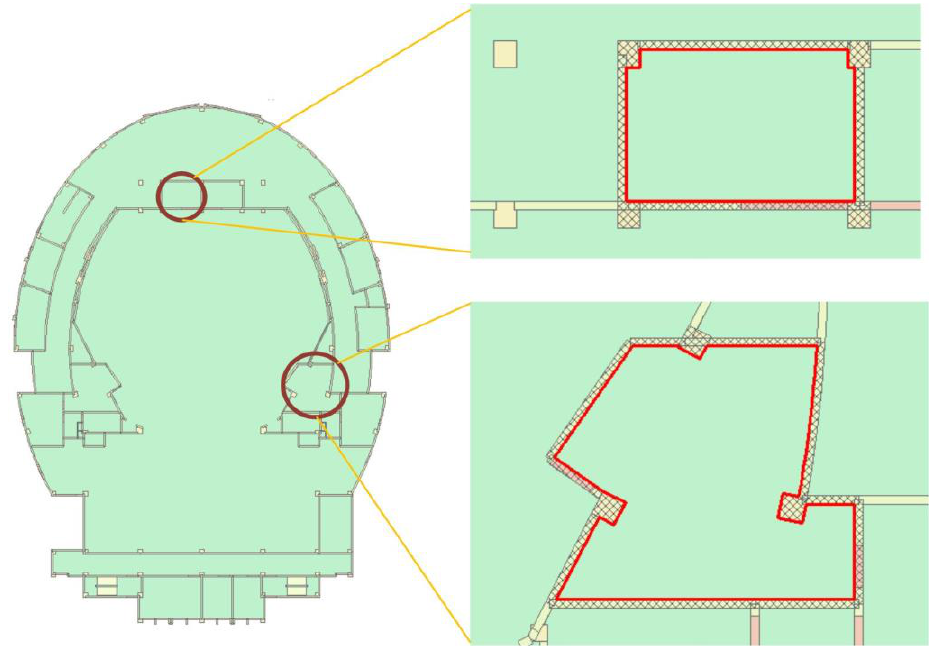
Figure 18. Boundary relationship.